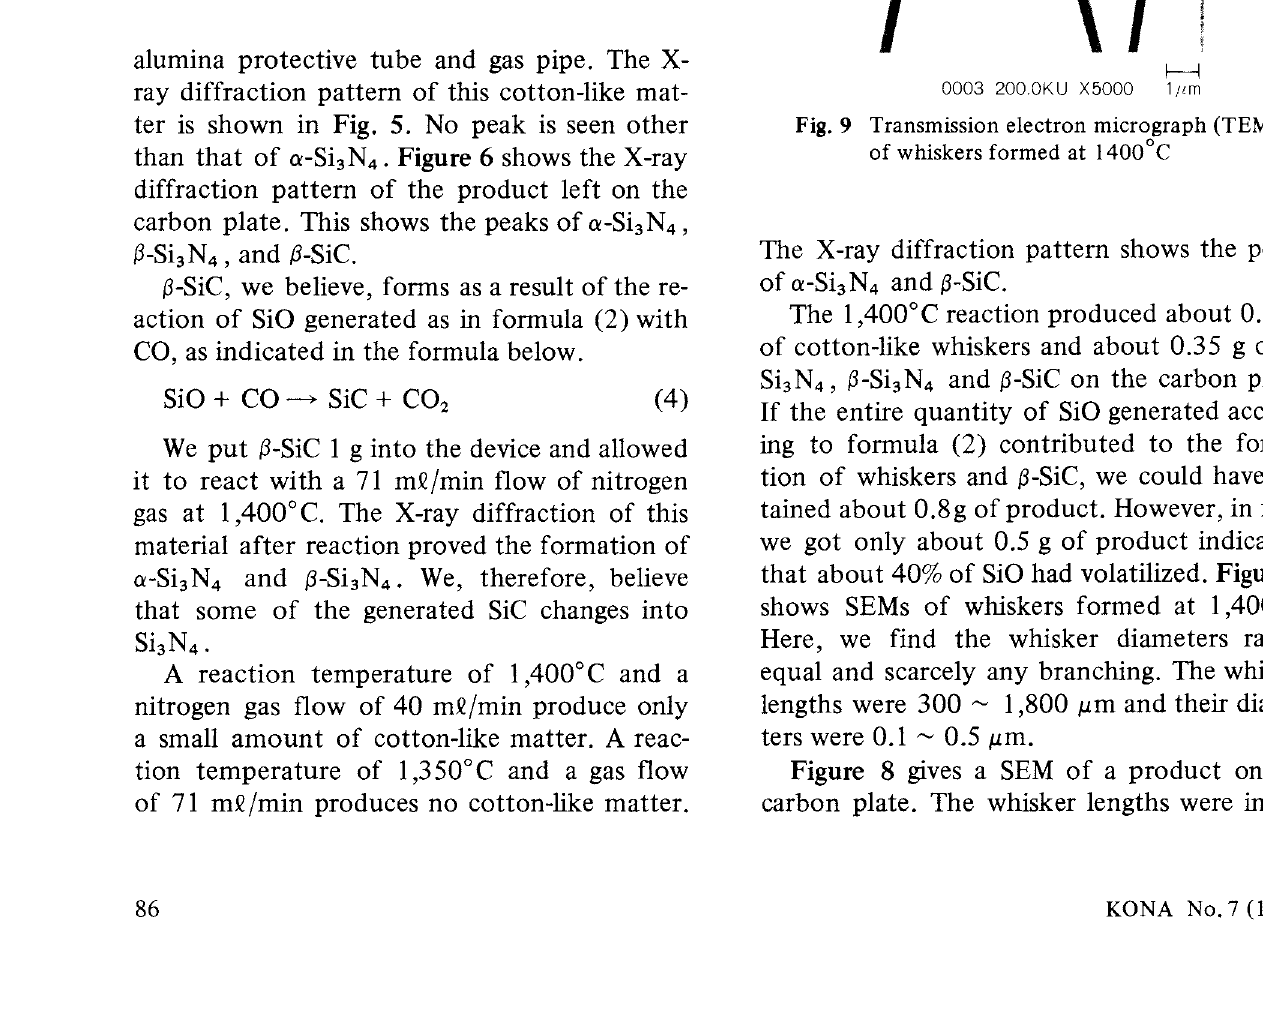
Fig. 8 Scanning electron micrograph (SEM)